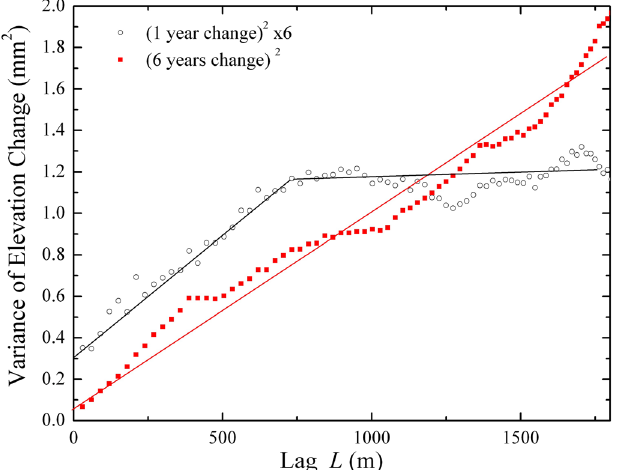
FIG. 6. Variances of the Tevatron alignment “ tie rod ” vertical displacements over time intervals of 1 yr (multiplied by 6) and 6 yr vs the distance L [57]. Solid lines are according to the ATL